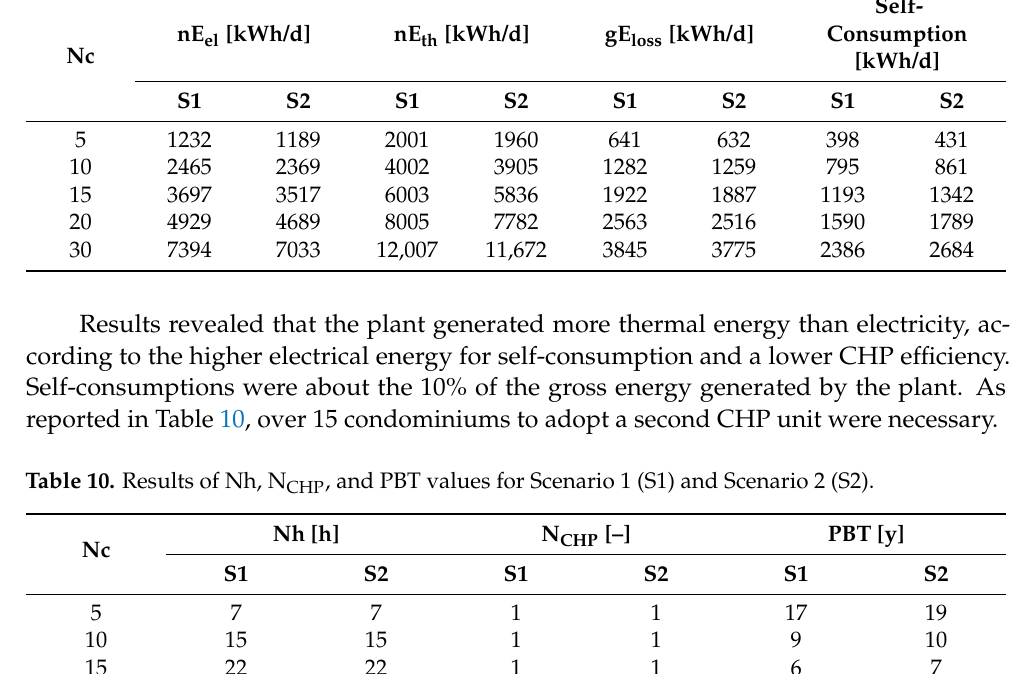
Table 9. Results of nE el , nE th , gE loss , and self-consumption energy values for Scenario 1 (S1) and Scenario 2 (S2).